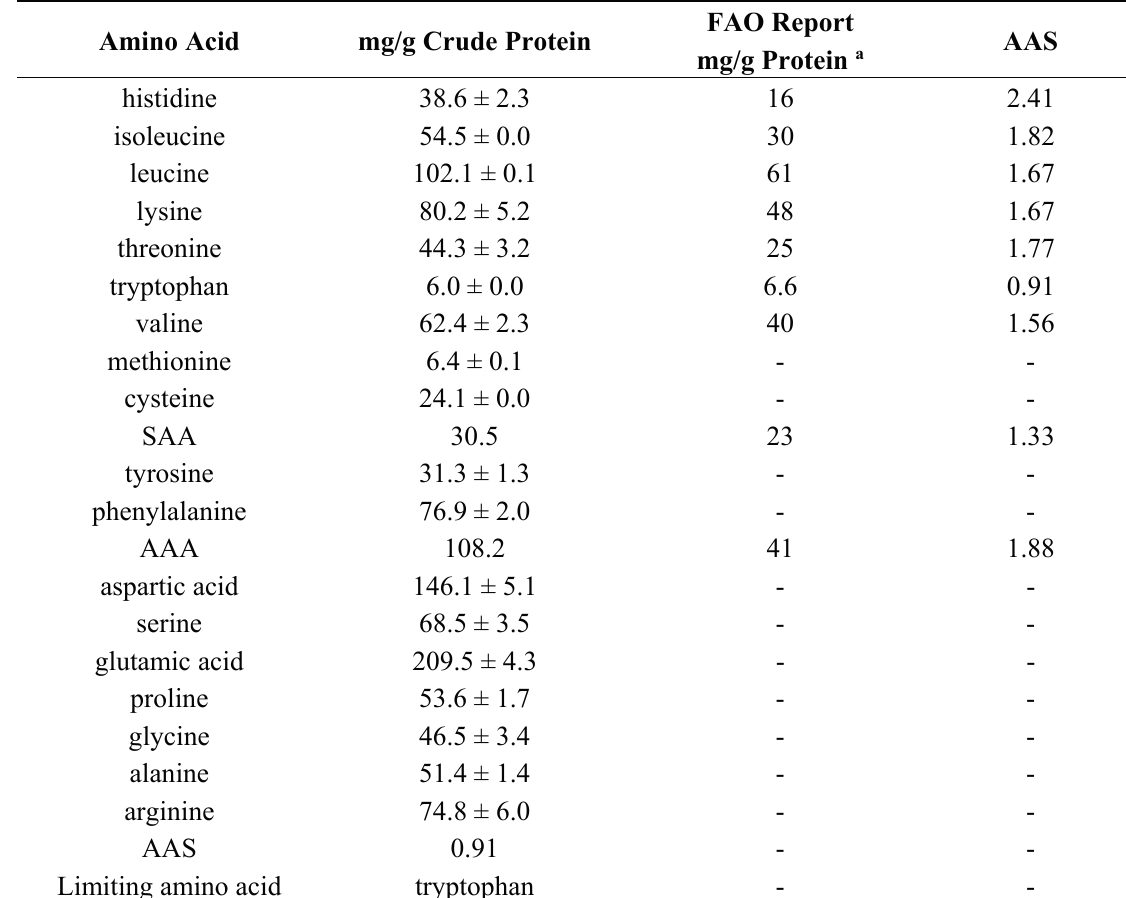
Table 2. Amino acid contents (mean ± S.D., n = 3) and amino acid score (AAS) of protein in Bambara groundnut a